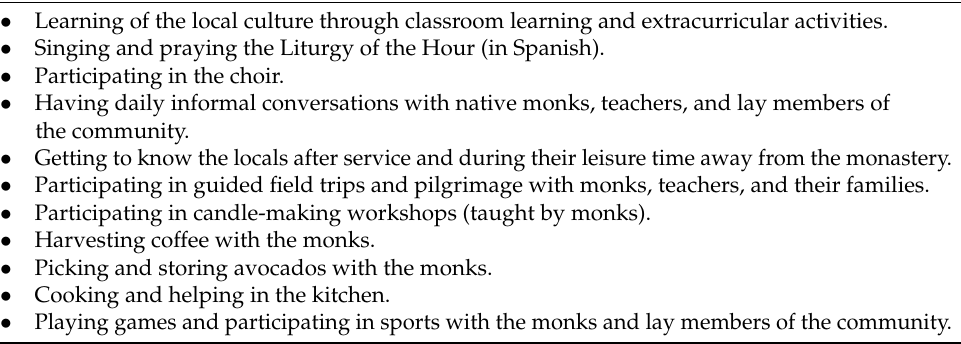
Table 4. Types of Liminal/Liminoid Learning Encounters. Types of Liminal/Liminoid Learning Encounters at the Benedictine Monastery of Our